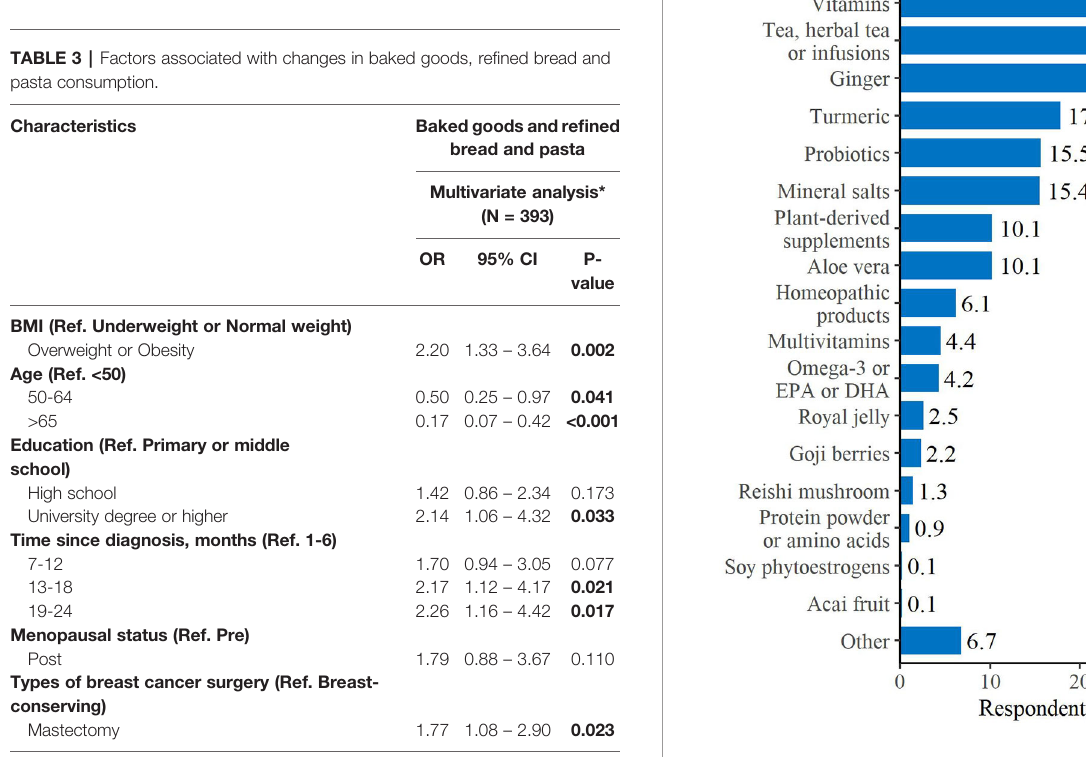
FIGURE 2 | Supplements used after breast cancer diagnosis. Respondents could select more than one answer. “ Other ” includes: fruit extract/fruit juice, mushrooms, propolis/pollen and